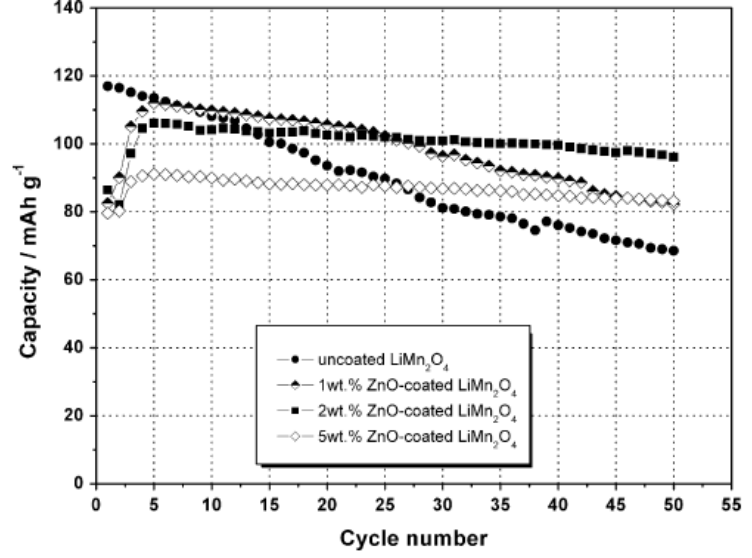
Figure 3. Capacity vs. cycle number profiles of uncoated and ZnO-coated LiMn at 55 ºC, between 3.4 V and 4.3 V. Adapted from [27]. Copyright 2007